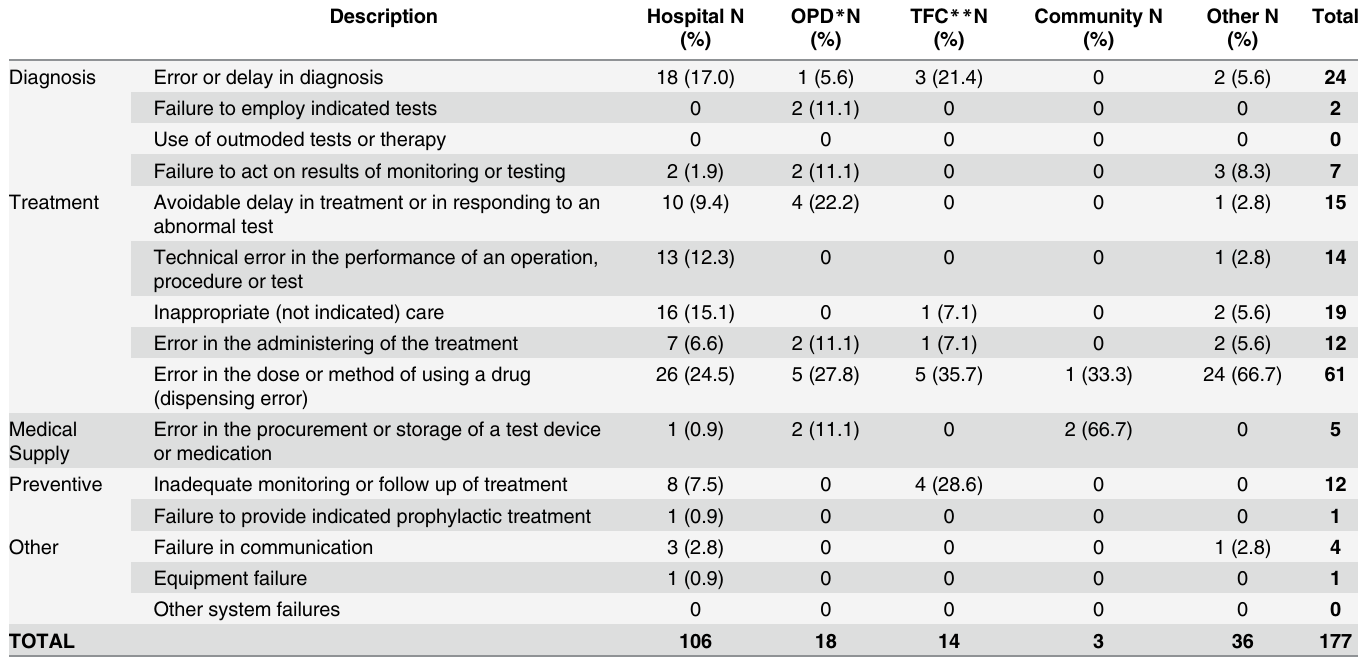
Table 3. Type of Error Classified by Site where Error Occurred.